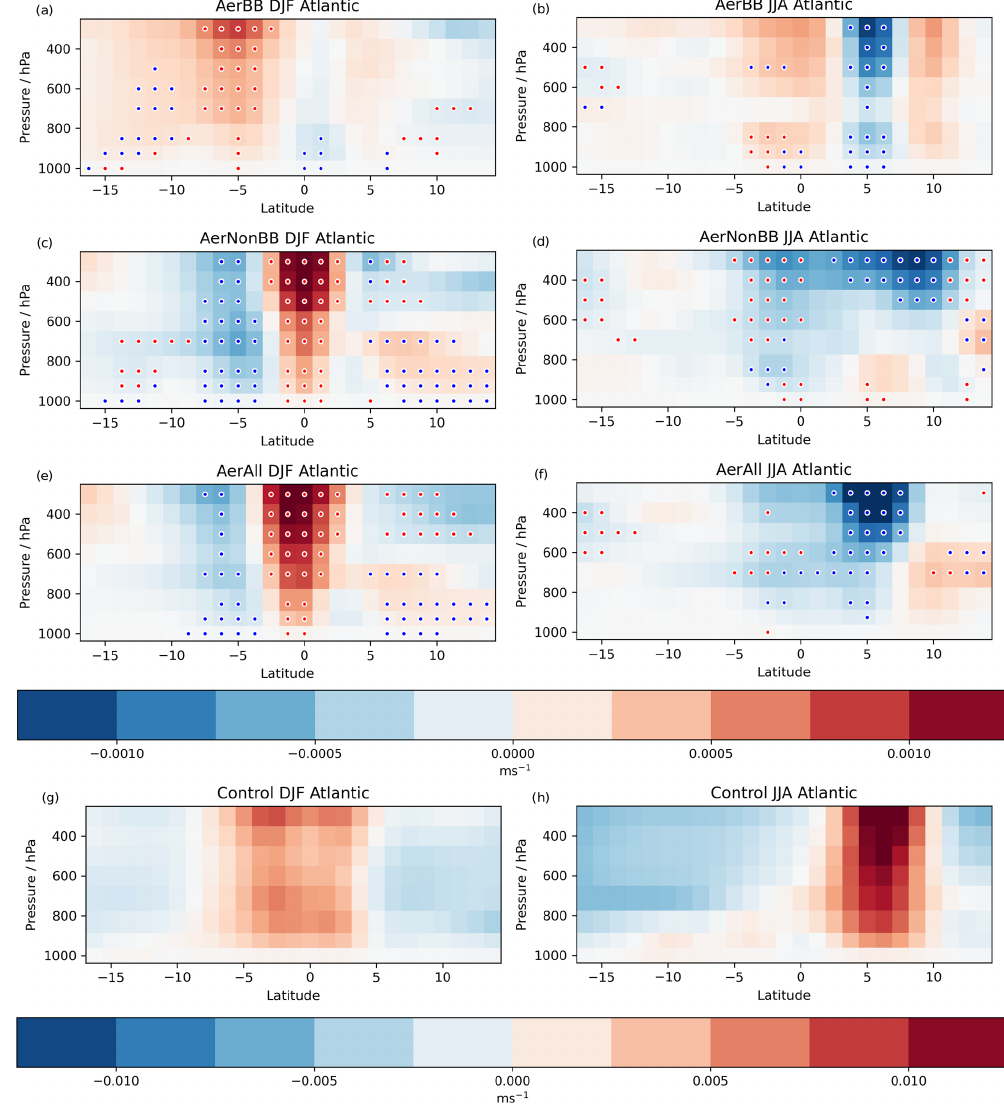
Figure 6. Vertical velocity changes zonally over the Atlantic in DJF and JJA for the three aerosol perturbations minus the control (AerBB, AerNonBB, and AerAll) and for the period 2070–2100. The control background is also indicated (g, h) . The Atlantic here is 40–15 ◦ W, narrower than the length at the Equator to avoid including land between 15 ◦ S and 15 ◦ N. Stippling indicates grid cells where the change is significant with respect to intra-ensemble variation, and it is coloured red when the change strengthens the background circulation and blue when